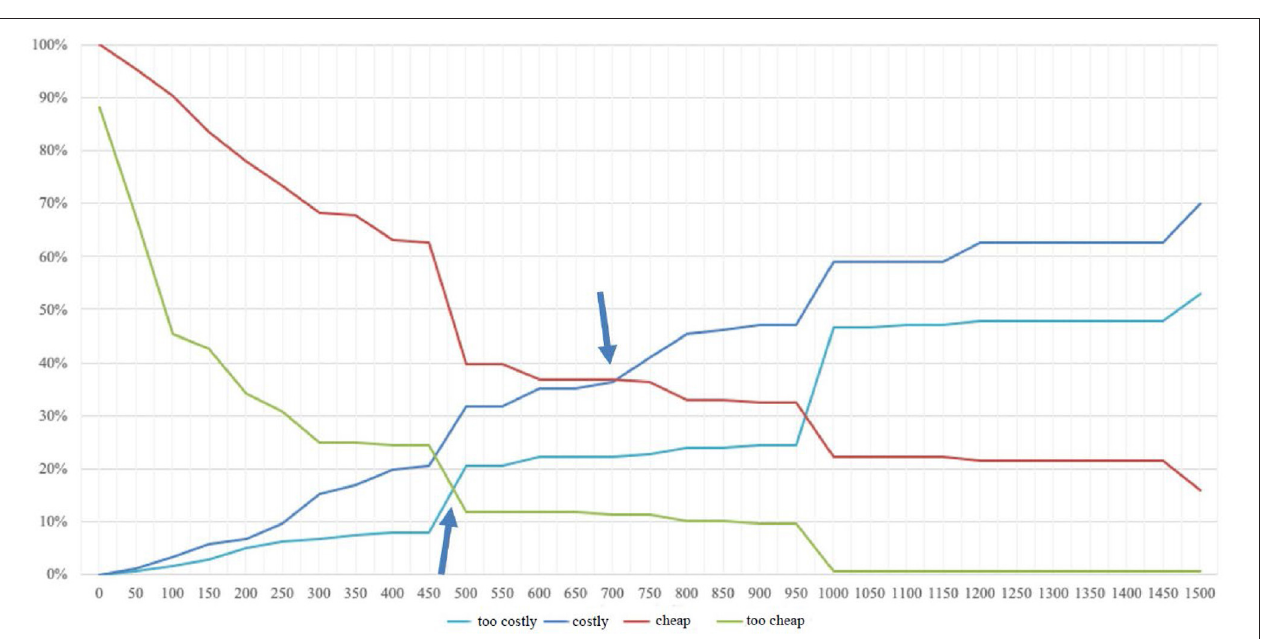
FIGURE 3 | Determination of the optimal price point according to Van Westendorp